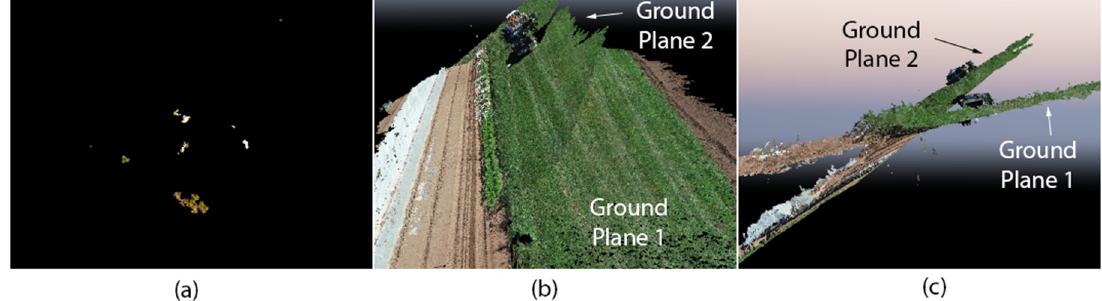
Figure 1. Failed models from the photogrammetry process: ( a ) A model that generated only a few scattered points; ( b ) a model that generated two intersecting ground planes; ( c ) a side view of the intersecting ground planes in ( b ).